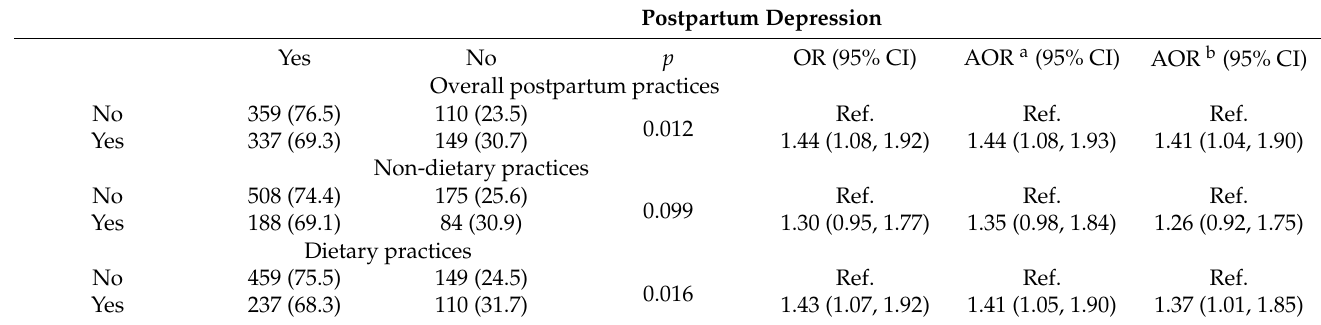
Table 2. Postpartum depression among women with traditional postpartum practices or not ( n , %).